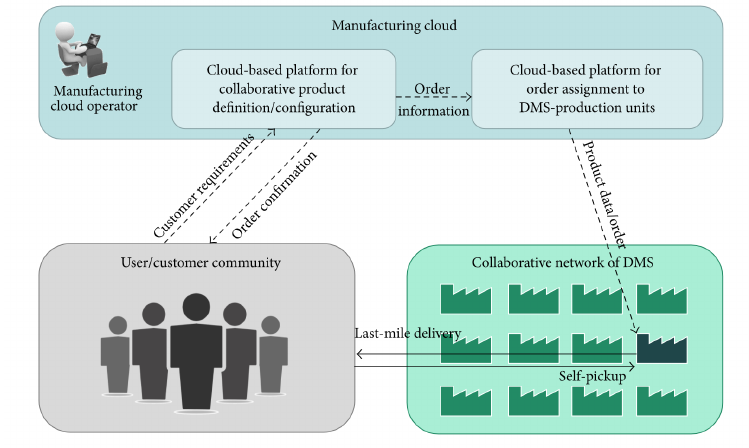
Figure 6. Collaborative cloud manufacturing model taken from